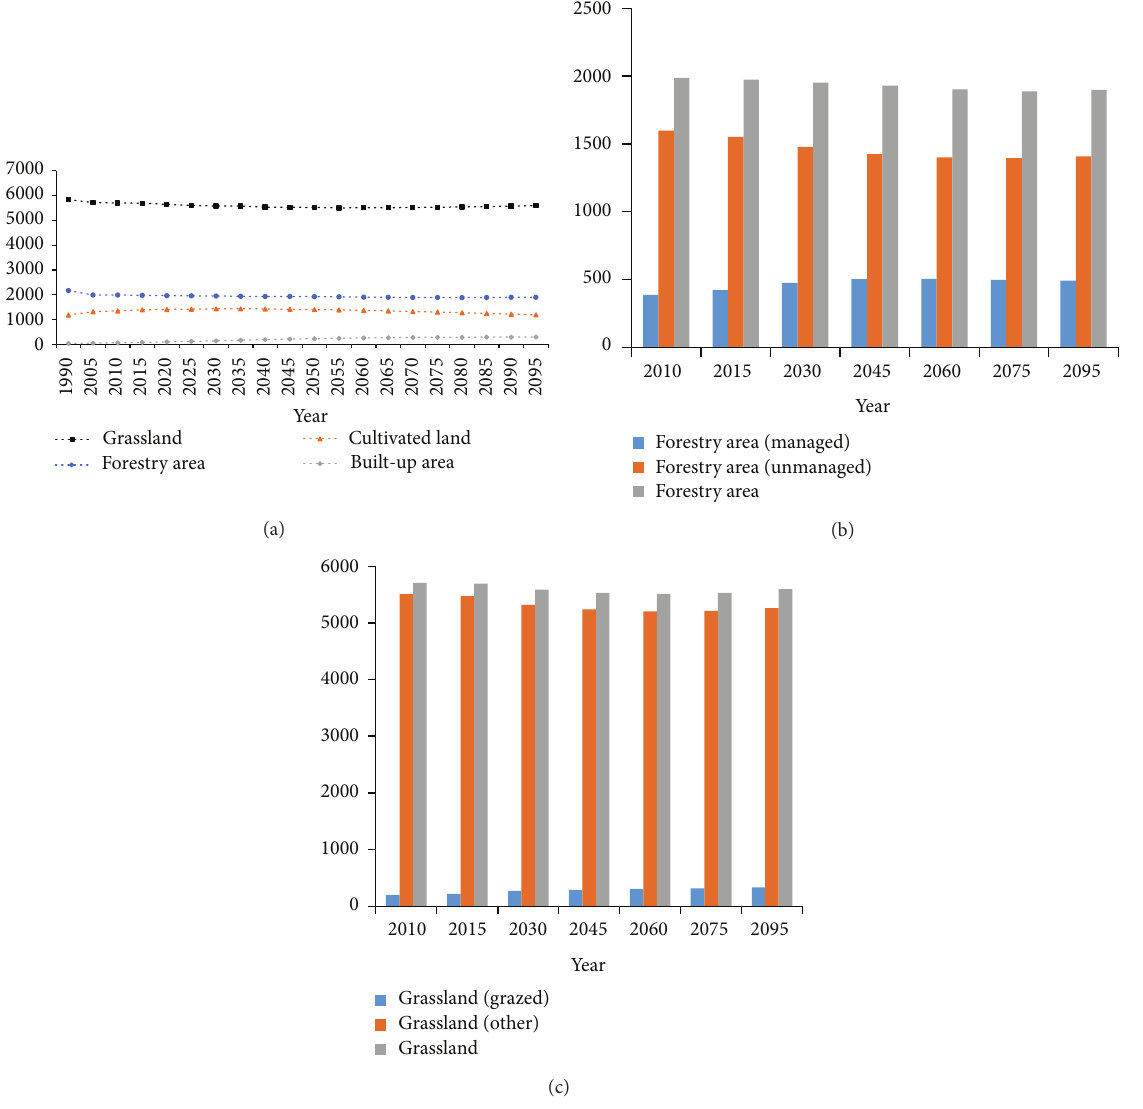
Figure 5: Land use change trends of China under CES scenario during 1990–2095: (a) land use change trends of cultivated land, forest land, grassland, and built-up land; (b) trends of managed and unmanaged forest land; (c) trends of grazed and other grassland (unit: 1000km 2